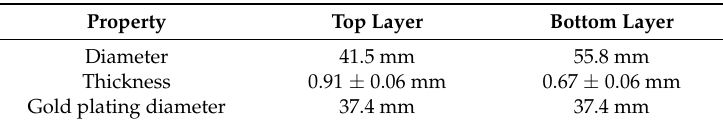
Table 1. Geometric properties of the dual layer sample.